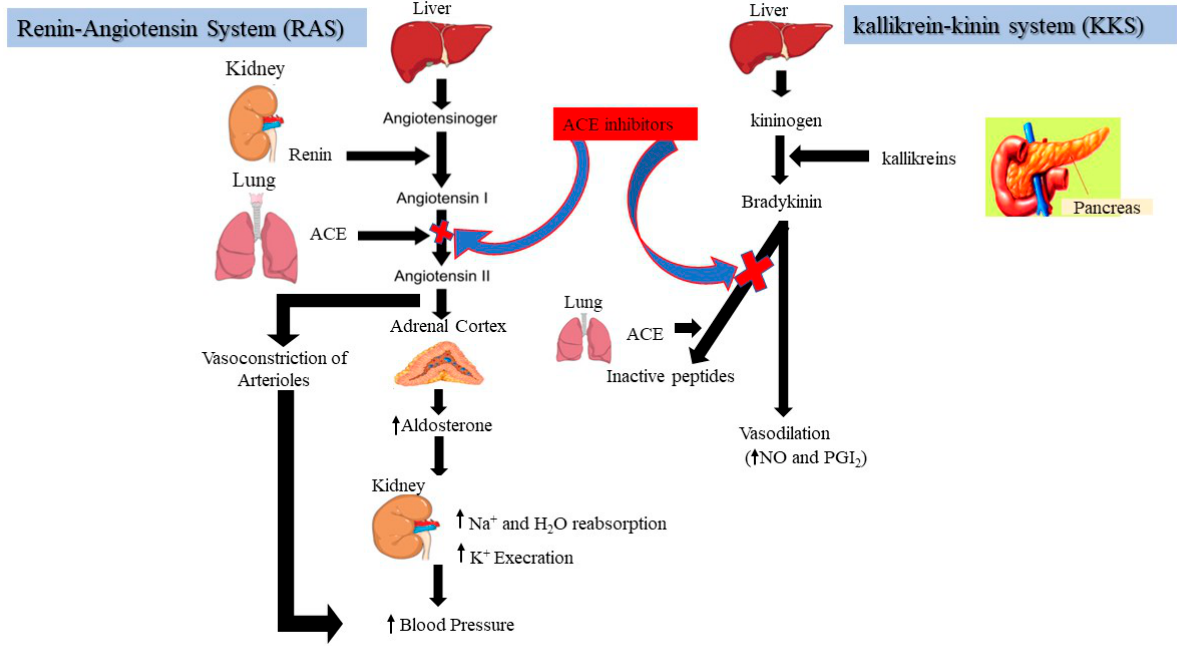
Figure 2. Schematic representation of the role of the renin-angiotensin system (RAS) and the kallikrein- kinin system (KKS) in blood pressure regulation. (Na + : Sodium; K + : Potassium; NO: Nitric Oxide; PGI2: Prostaglandins 2.